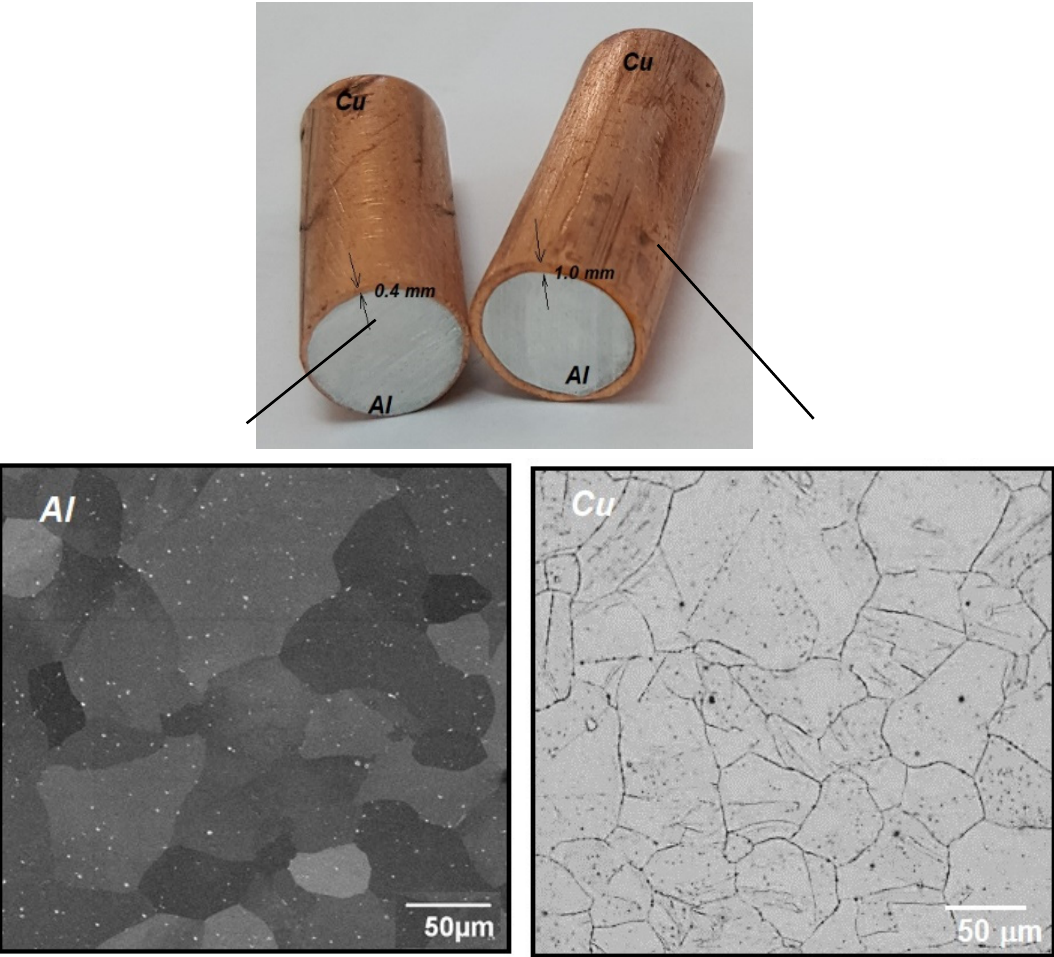
Figure 1. Aluminium rods cladded by copper with different thicknesses before deformation. (The left image is a backscattered SEM image and the right one is an optical microscope image.).